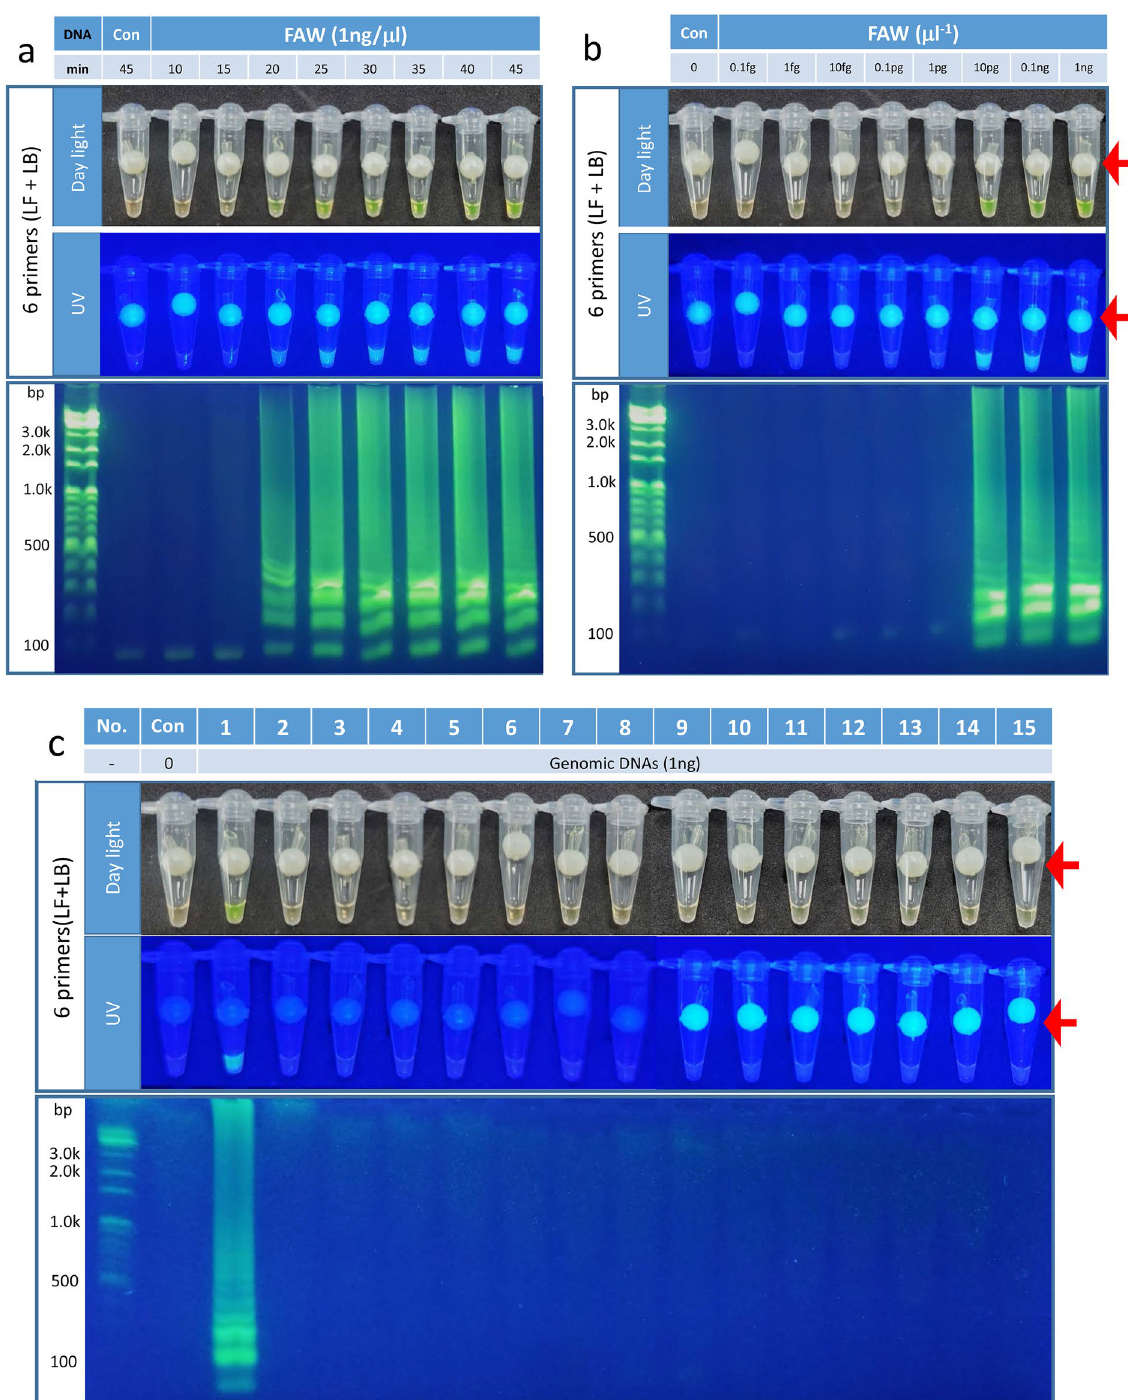
Figure 3. Improved efficiency of the Sf6p-LAMP assay with FAW species specificity. ( a ) After 20 min of incubation in Sf6p-LAMP assays, the fluorescence signals and amplification of DNA fragments were detected. In addition, the fluorescence signals and patterns of amplified DNA fragments were similar in Sf6p-LAMP assays after 25 min of incubation. ( b ) Since the fluorescence signal and DNA amplification were identified above 10 pg/μl, the detection limit for the Sf6p-LAMP assays was 10 pg/μl. ( c ) When 1 ng of genomic DNA from 15 moth species was used for Sf6p-LAMP assay, clear fluorescence signals and amplification of DNA fragments were detected from FAW genomic DNA only. Moth species used in this study were as follows: 1. FAW, 2 . Axylia putris , 3 . Mythimna loreyi , 4. Discestra trifolii , 5. Hermonassa cecilia , 6. Anomis flava , 7. Aedia leucomelas , 8. Pleuroptya ruralis , 9. Mythimna separata , 10. Lacanobia contigua , 11. Helicoverpa armigera , 12. Mamestra brassicae , 13 . Spodoptera exigua , 14. Spodoptera litura , 15. Plutella xylostella. The red arrows indicate the contamination-free SYBR green delivery